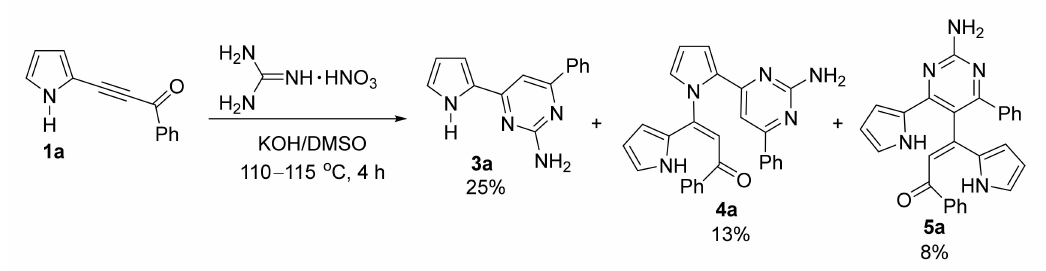
Scheme 4. The reaction of 2-benzoylethynylpyrrole 1a with guanidine